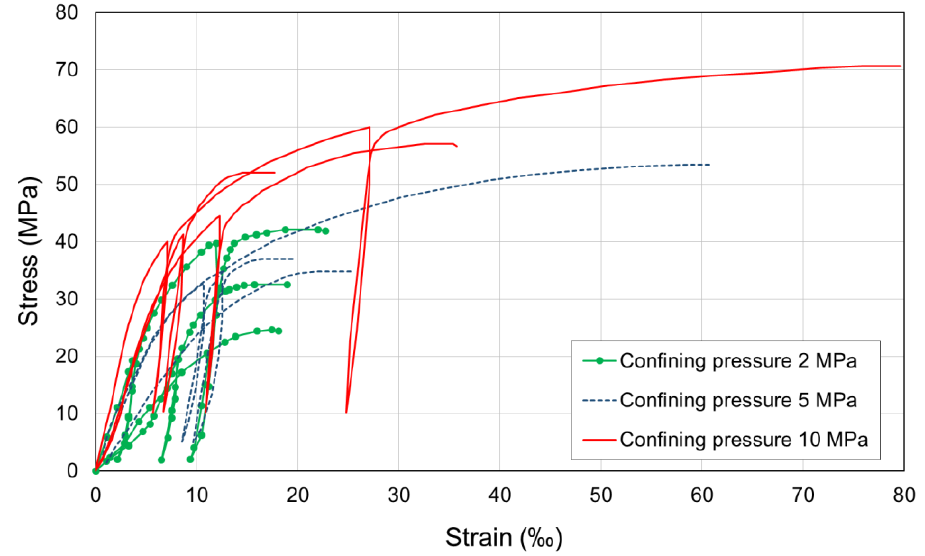
Figure 11. Stress–strain characteristics of the Brown Zuber unit samples—conventional triaxial compression tests at a constant stress rate (according to [58]).